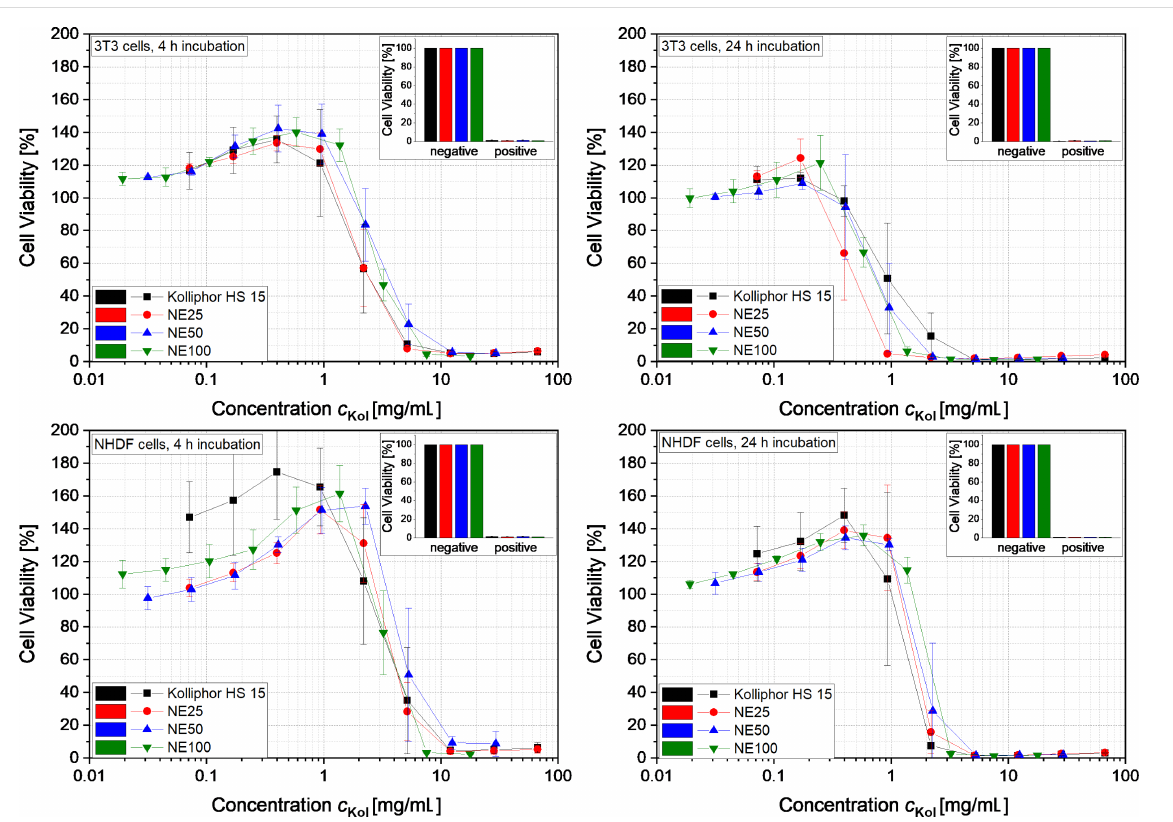
Figure 7: Viability of the cells of lines 3T3 and NHDF as a function of the Kolliphor HS 15 concentration c Kol in the nanoemulsions NE25, NE50 and NE100 as well as the aqueous Kolliphor HS 15 solution ( n = 3).